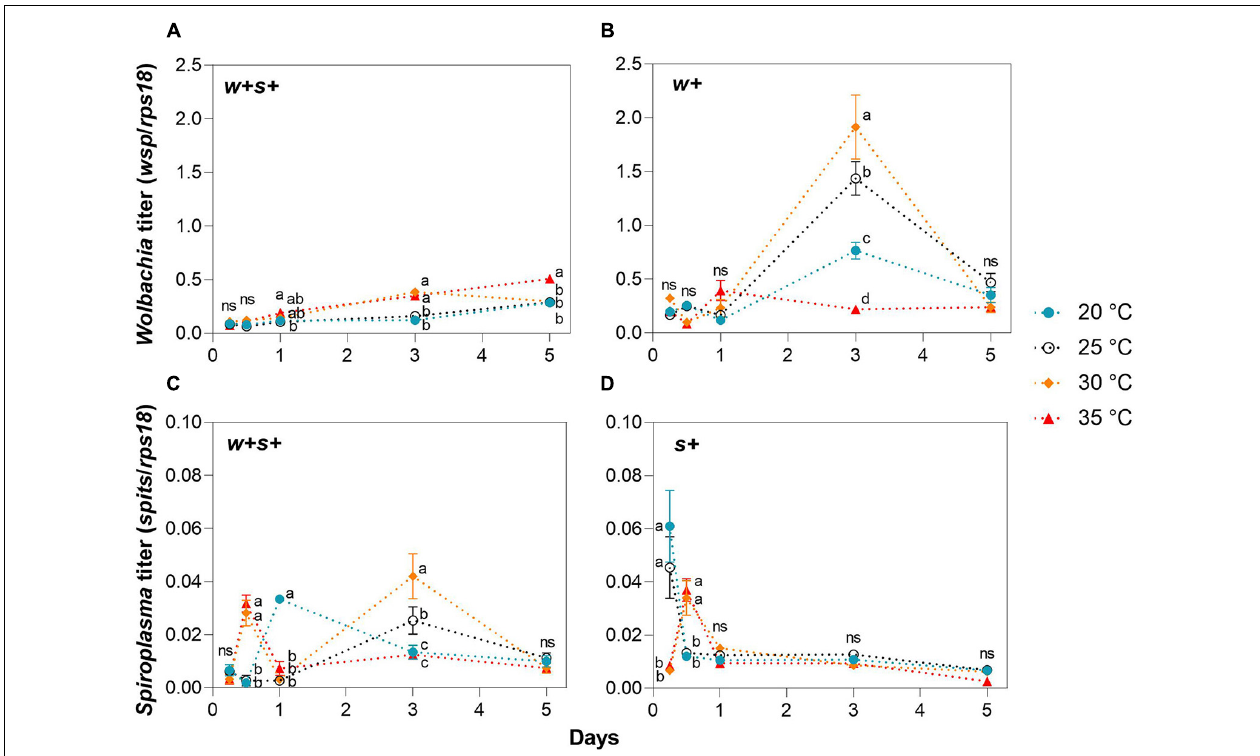
FIGURE 3 | Wolbachia and Spiroplasma densities in female adult spider mites maintained under low (20 ◦ C) and high (30 or 35 ◦ C) temperatures for up to 5 days. Wolbachia density in co-infected strains (A) and Wolbachia -infected strains (B) . Spiroplasma density in co-infected strains (C) and Spiroplasma -infected strains (D) . Data are shown as the mean ± SEM. Different letters indicate significant differences between each treatment at the same time point ( p < 0.05; ns, no